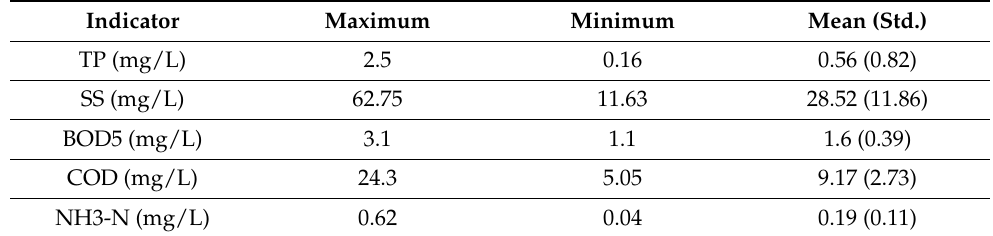
Table 1. Descriptive statistics of the runoff water quality parameters. Indicator Maximum Minimum Mean (Std.) TP